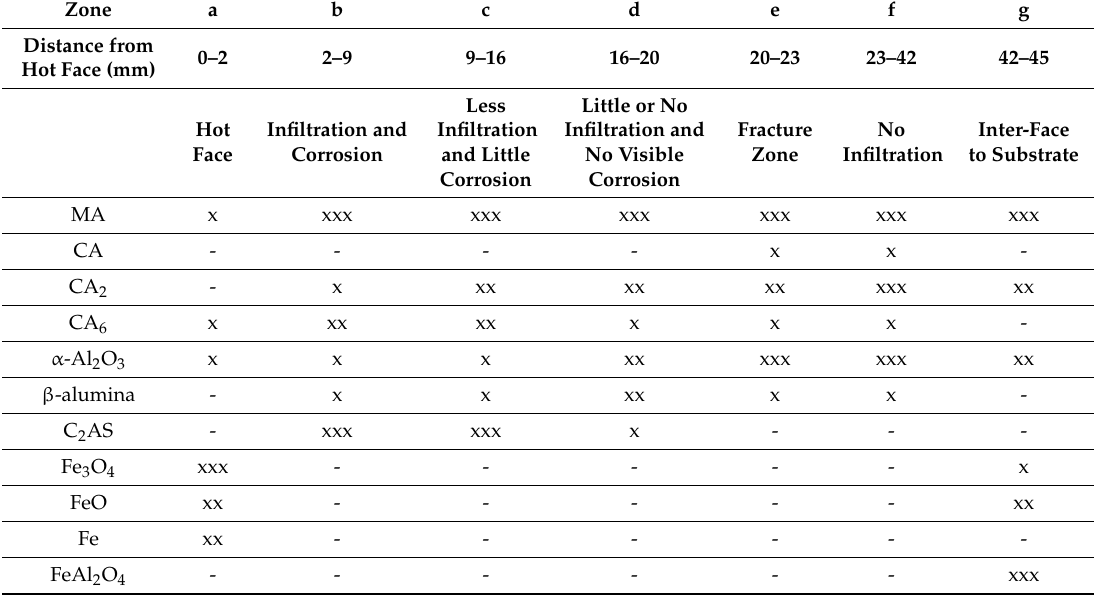
Table 6. XRD-phase analyses of the di ff erent zones of